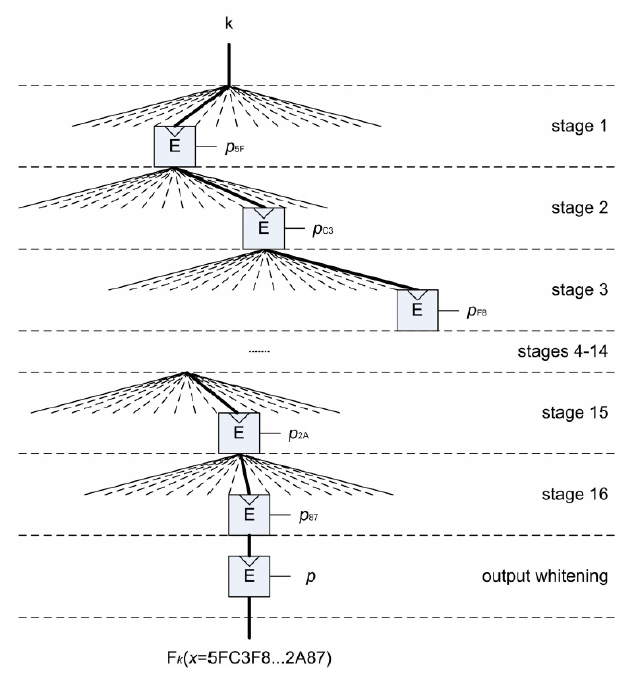
Figure 1: LR-PRF construction from [MSJ12] with n b = 8 (illustration from [MSJ12]).